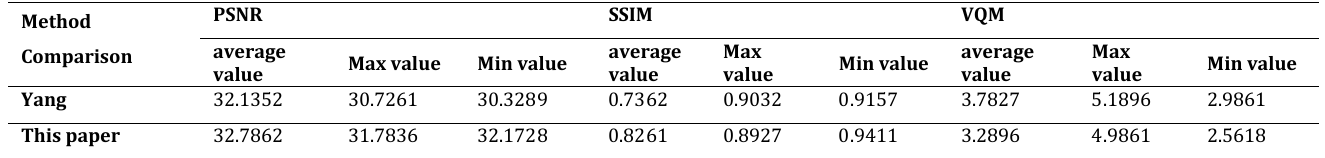
Table 1: Two algorithms comparison of data in three evaluation categories